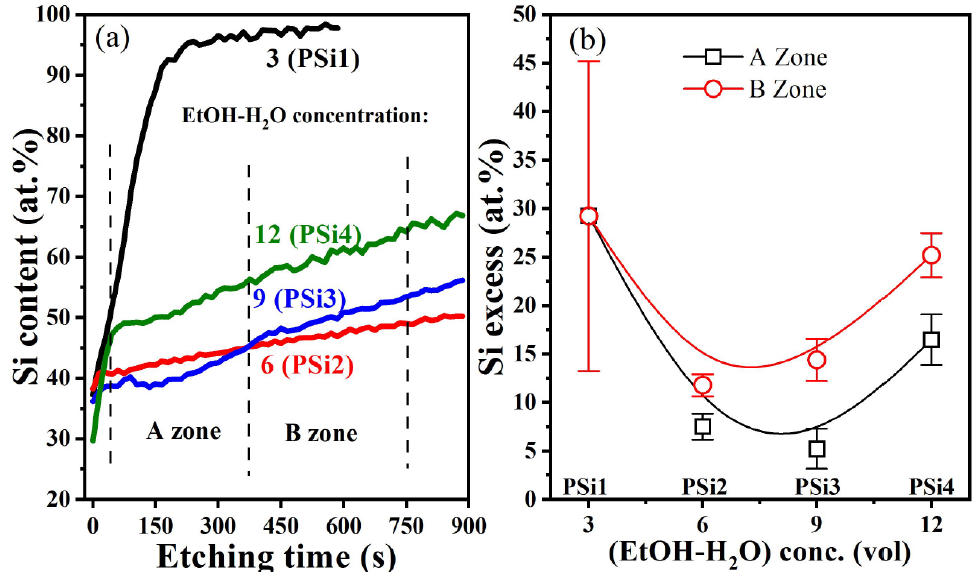
Figure 3. Si content ( a ) in the depth profile and ( b ) as a function of the EtOH-H 2 O concentration for the different PSi films. Labels PSi1-PSi4 are also indicated for clarity in their respective EtOH-H 2 O concentrations for clarity.